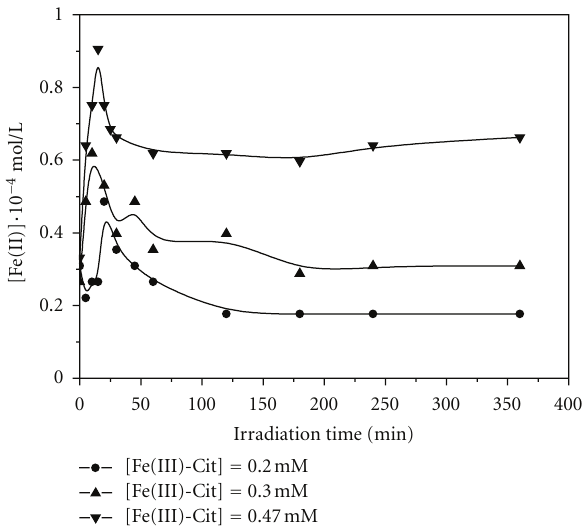
Figure 14: m-cresol disappearance in the mixture upon irradiation (365nm): (cid:8) bubbling O 2 , (cid:5) without O 2 . Inset displays: (cid:5) photol- ysis of m-cresol, (cid:3) photodegradation of m-cresol in the absence of oxygen.